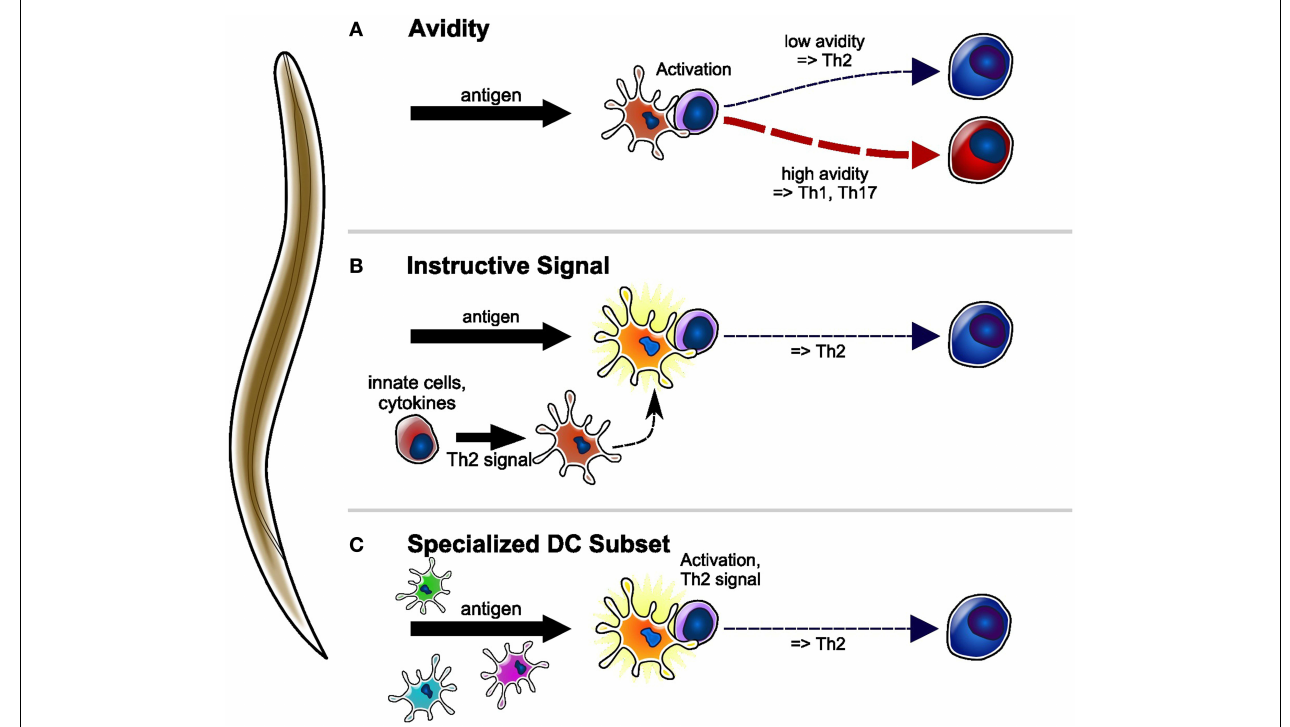
innate cytokines/cells, or directly conditioned by parasite products, acquire the ability to primeTh2 responses.Th1 and/orTh17 responses are initiated by DC conditioned by other innate signals. (C) A specific DC subset that is uniquely able to take up parasite material is programed to primeTh2 immune responses.The priming of otherT-cell phenotypes requires other DC